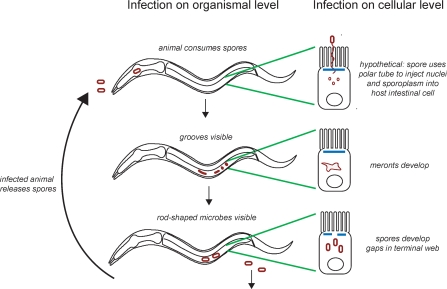
Model of N. parisii Infection in C. elegans on Cellular and Organismal LevelSee text for details.